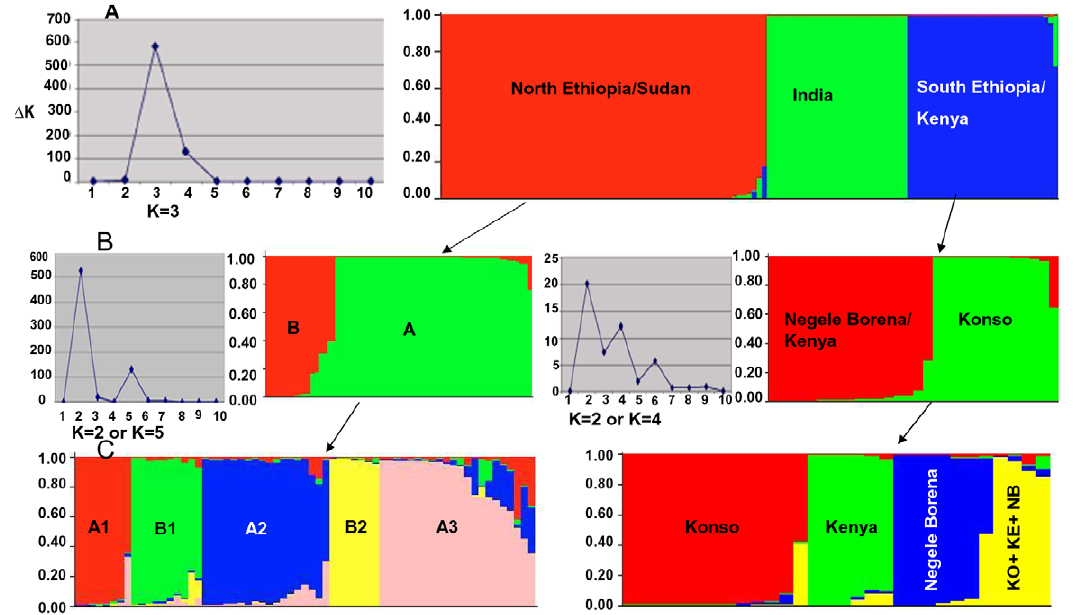
Figure 2. Populations, subpopulations and clusters for 123 L.donovani strains as inferred by STRUCTURE. The peak at D K represents the most probable number of populations and subpopulations. Presence of smaller peaks in D K plot for the subpopulations indicated the presence of further clustering. A ) Three main populations: North Ethiopia/Sudan (NE/SD), India, and South Ethiopia/Kenya (SE/KE) were identified in the whole data set of 123 strains. B ) Within each East African population, two subpopulations were identified, A and B in the NE/SD population, and Konso and NB/KE in the SE/KE population. C ) Five clusters were apparent, three (A1, A2 and A3) in the NE/SD-A subpopulation and two (B1 and B2) in the NE/SD- B subpopulation. Four clusters were detectable in the SE/KE population, named Konso, Kenya, Negele Borena and KO + KE + NB. Each strain is represented by each vertical line in the STRUCTURE bar plot. Strains with mixed membership to the different populations, subpopulations or clusters are represented by different colored segments of the vertical bar which is proportional to the membership coefficient. The maximum membership coefficient is 1 meaning that a strain is a member in only one population, subpopulation or cluster.